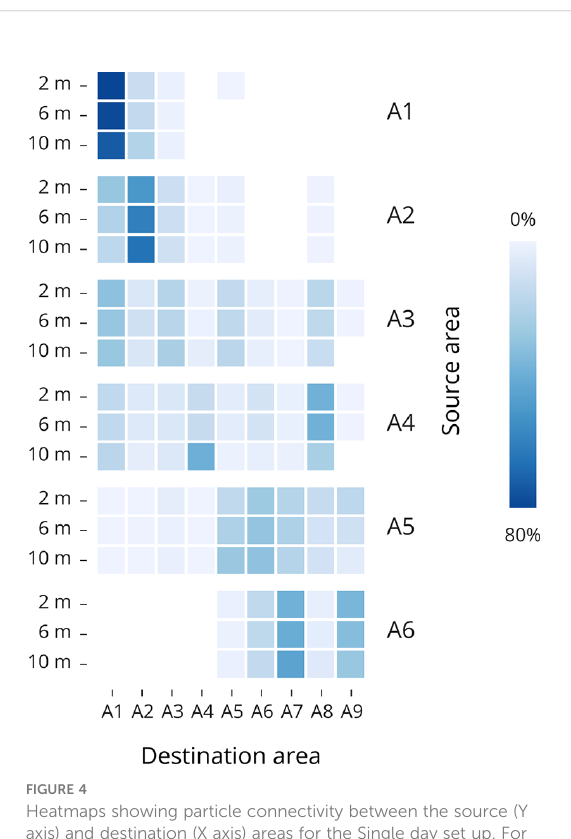
FIGURE 4 Heatmaps showing particle connectivity between the source (Y axis) and destination (X axis) areas for the Single day set up. For the years 2021, the accumulation for each source region was averaged for March, April, and May at each depth. Dark blue boxes represent area with high particle accumulation, whereas light blue to white boxes represent areas with lower particle accumulation in percent. Supplementary Table S3 has detailed means and standard